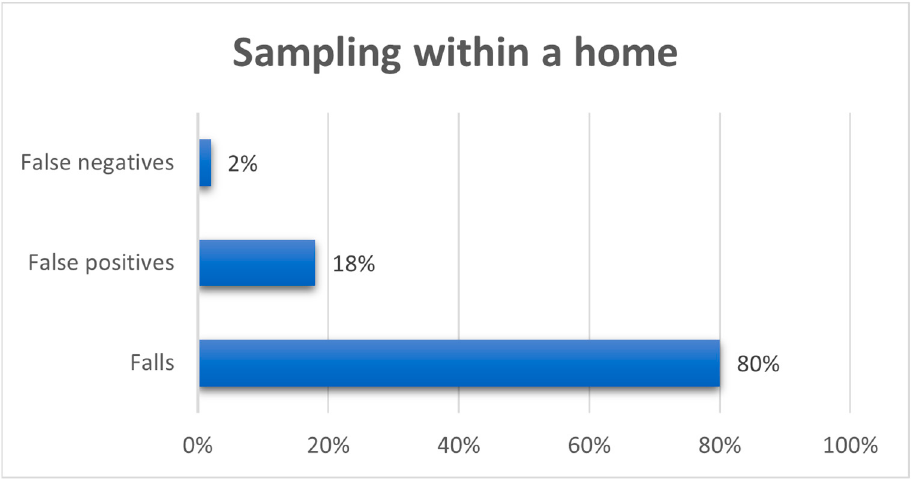
Figure 7. Sampling done in the living room of an average home.